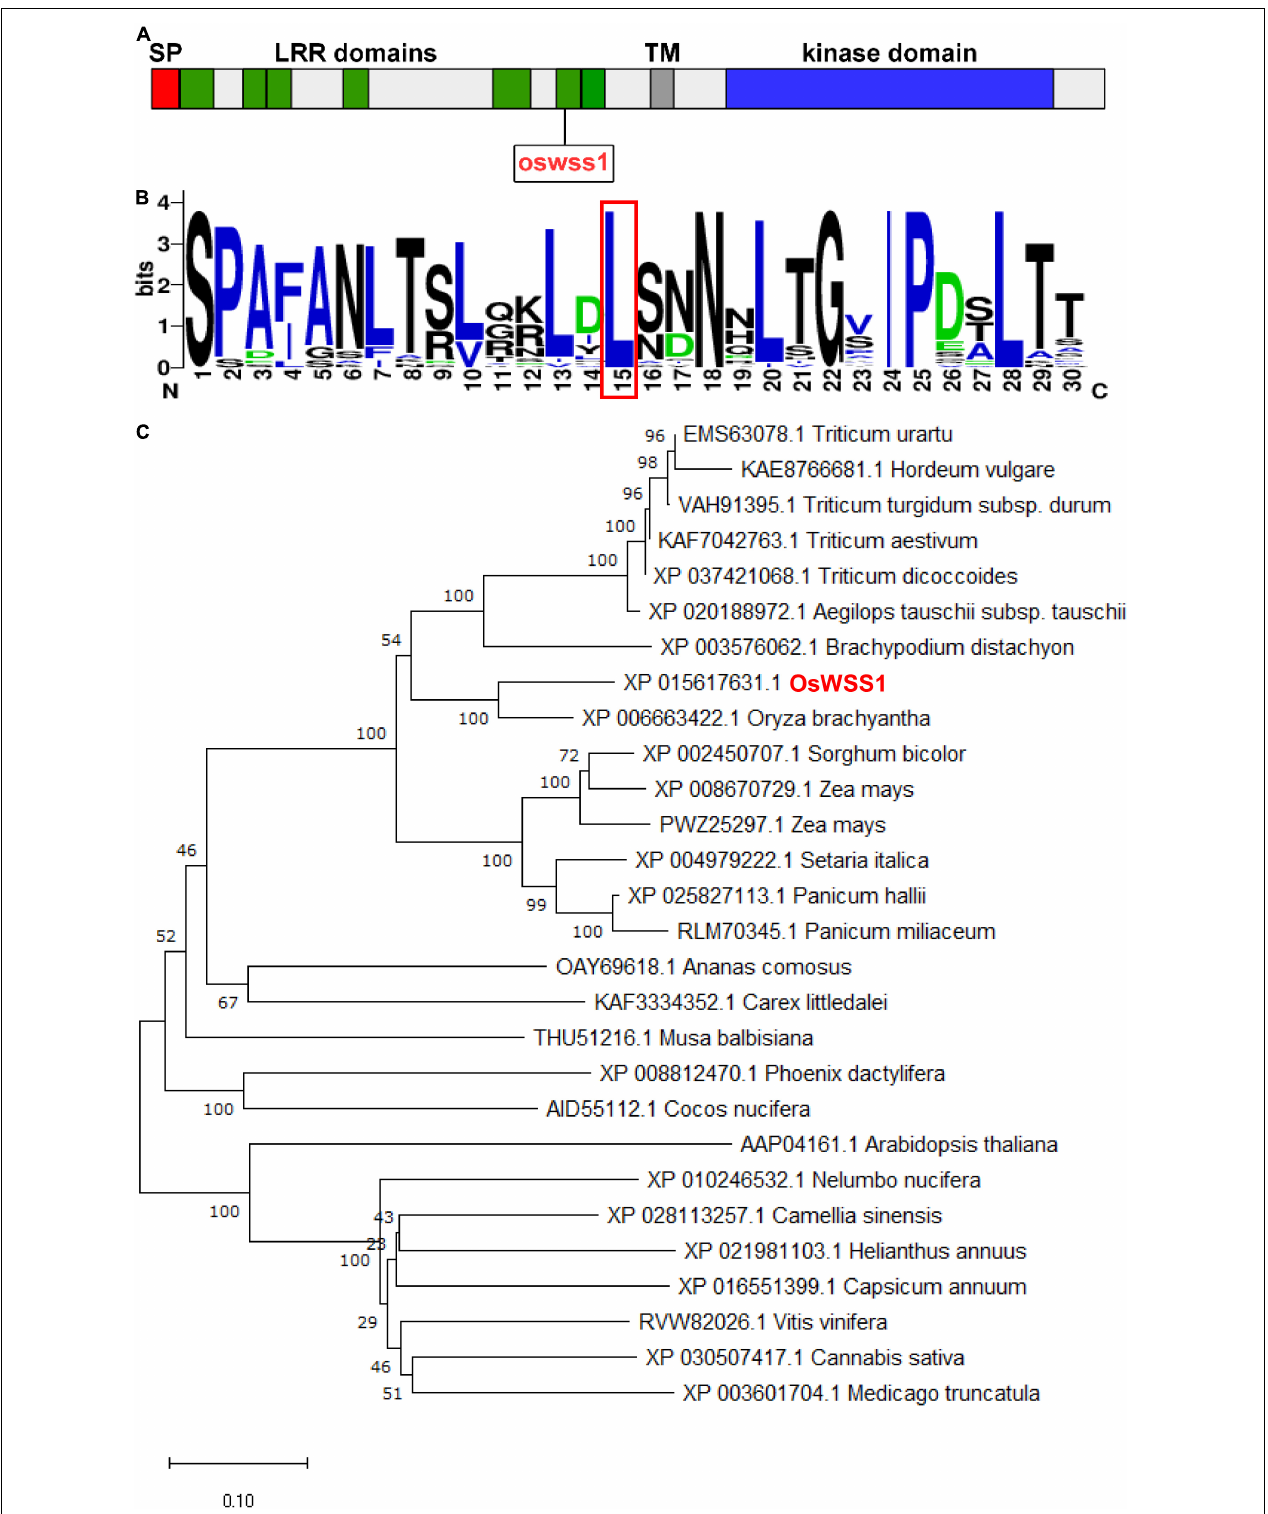
FIGURE 5 | Phylogenic analysis of OsWSS1. (A) Schematic diagram of the OsWSS1 protein. SP, signal peptide; LRR domain, leucine-rich repeat region; TM, transmembrane domain. The rectangle indicates the position of the point mutation of the OsWSS1 in the oswss1 mutant. (B) Conservation analysis of the amino acid substitution region and the frequency of the 50 homologous genes. The red-boxed region indicates the position of the amino acid transition. (C) Phylogenetic tree of the OsWSS1 protein. OsWSS1 is highlighted in red. The phylogenetic tree was constructed using MEGA 7.0 with the neighbor-joining method and 1,000 bootstrap